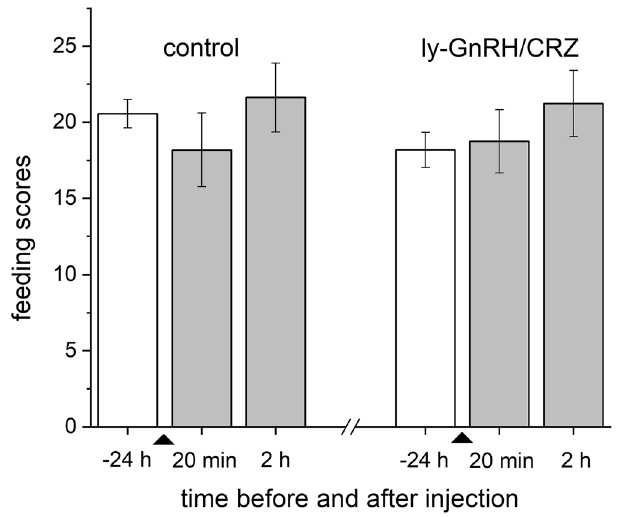
Figure 2. Feeding activity (number of rasps/2 min) of experimental groups. White and grey columns represent the score before and after injection, respectively. Each bar represents mean ± SEM (n = 10 animals/group/ replicates). Triangles indicate the time point of peptide injection. No significant differences were observed between the control and ly-GnRH/CRZ injected